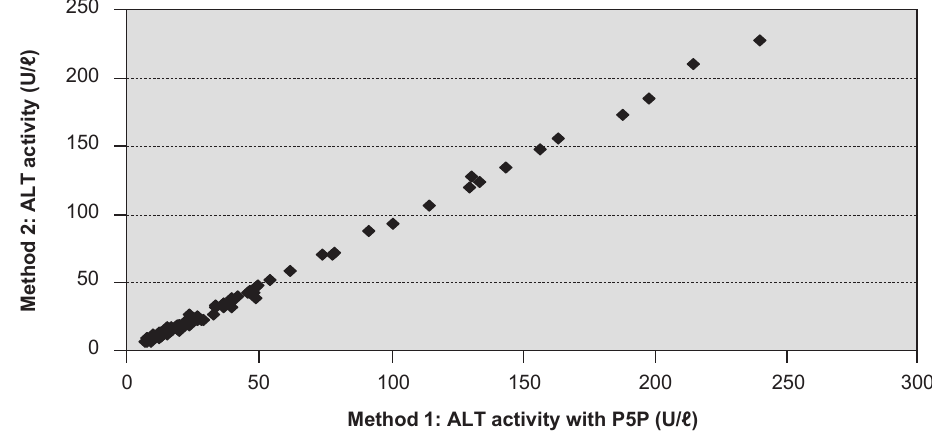
FIG. 2 Correlation of ALT measurements with P5P (Method 1) and ALT measurements without P5P (Method 2) in the dogs suffering from babesiosis TABLE 1 Correlation between Method 1 and Method 2 in the Babesia ­infected dogs with suspected hepatocellular damage ( n = 14) where serum ALT measured ≥ 1.7x the upper limit of the normal value Method 1 Method 2 t-value P -value (paired t-test) ALT with P5P ALT without P5P